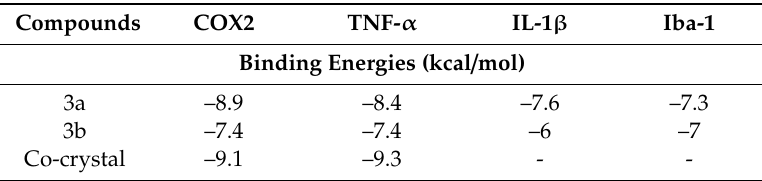
Table 1. Binding energy values after docking. IL, interleukin; TNF, tumor necrotic factor, COX, cyclooxygenase; Iba, ionized calcium-binding adapter molecule.